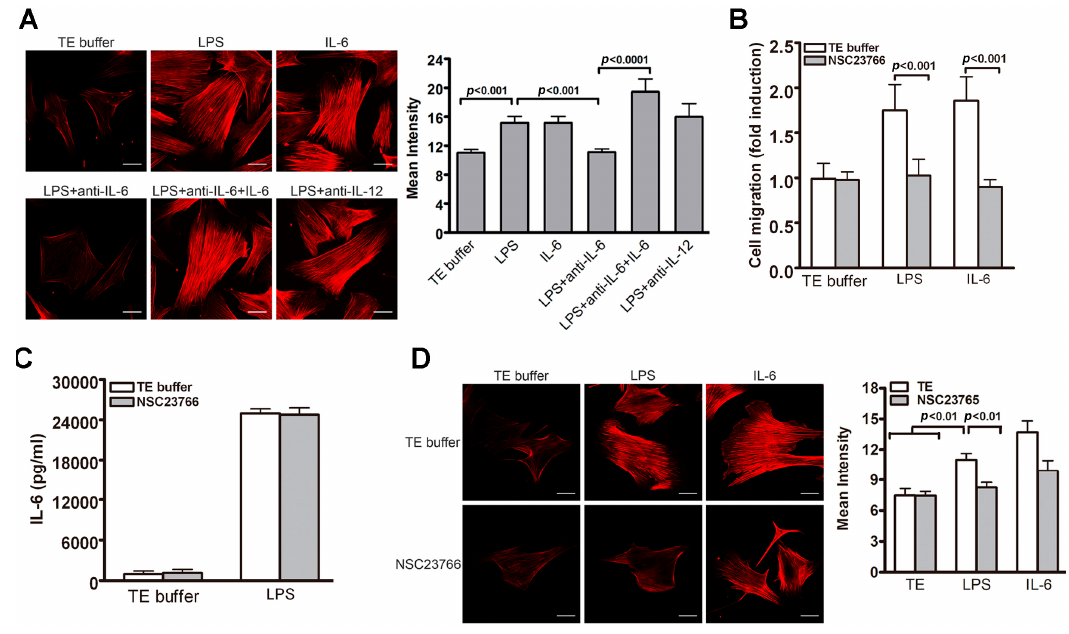
Figure 6. Role of Rac1-mediated F-actin formation in TLR4-induced VSMC migration. ( A ) VSMCs were subjected to different treatments (TE, LPS, IL-6, and in combination with anti-IL-6 or IL-12) for 24 h. Rhodamine-conjugated phalloidin staining was then performed to reveal actin stress fibers of VSMCs. The staining intensity was then quantified. p < 0.001 vs. LPS; p < 0.0001 vs. LPS + anti-IL6; ( B , C ) VSMCs were pretreated with Rac1 inhibitors NSC23766 (100 μ M) for 30 min before stimulation with TE buffer, LPS or IL-6 for 24 h; ( B ) Migration assays were performed using transwell assays and PDGF-BB as a chemoattractant. p < 0.001 for TE buffer vs. NSC23766; ( C ) ELISA was performed to determine IL-6 levels in culture medium; ( D ) VSMC Phalloidin staining and quantitative analysis of staining intensity. p < 0.01 vs. LPS with TE buffer. Representative images of three independent experiments are shown in A and D . Scale bar, 5 μ m. One-way ANOVA was used for statistical analyses in A – D .